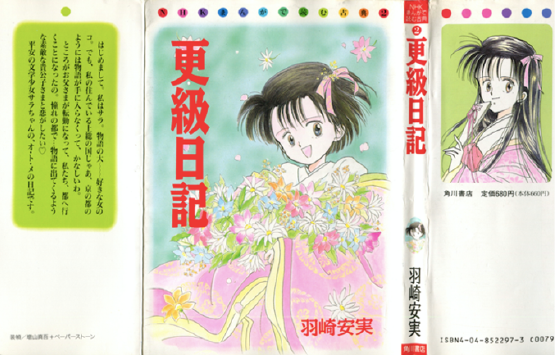
Figure 1. Manga 1991 dust cover, featuring Sara-chan’s self-introduction, and showing the heroine as a young girl (left) and an adolescent (right). Courtesy of